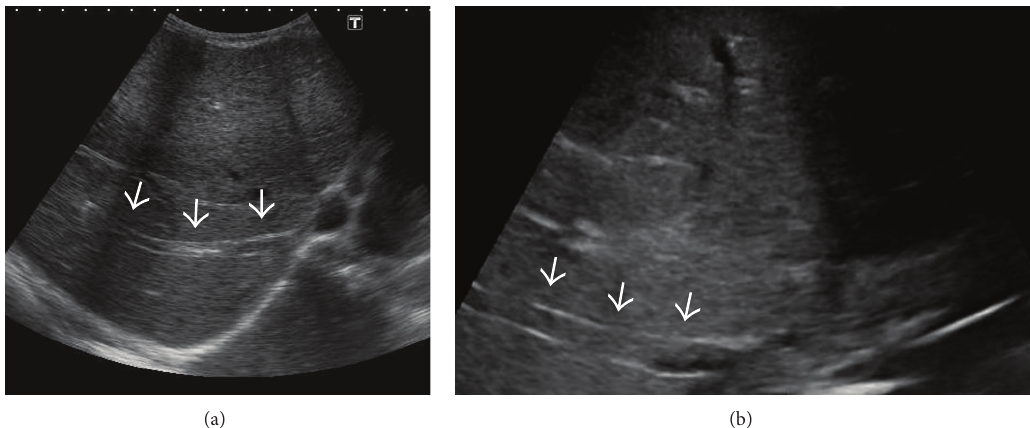
Figure 10: Gray-scale US images from two different patients demonstrating echogenic thrombus within the right hepatic vein (arrows).